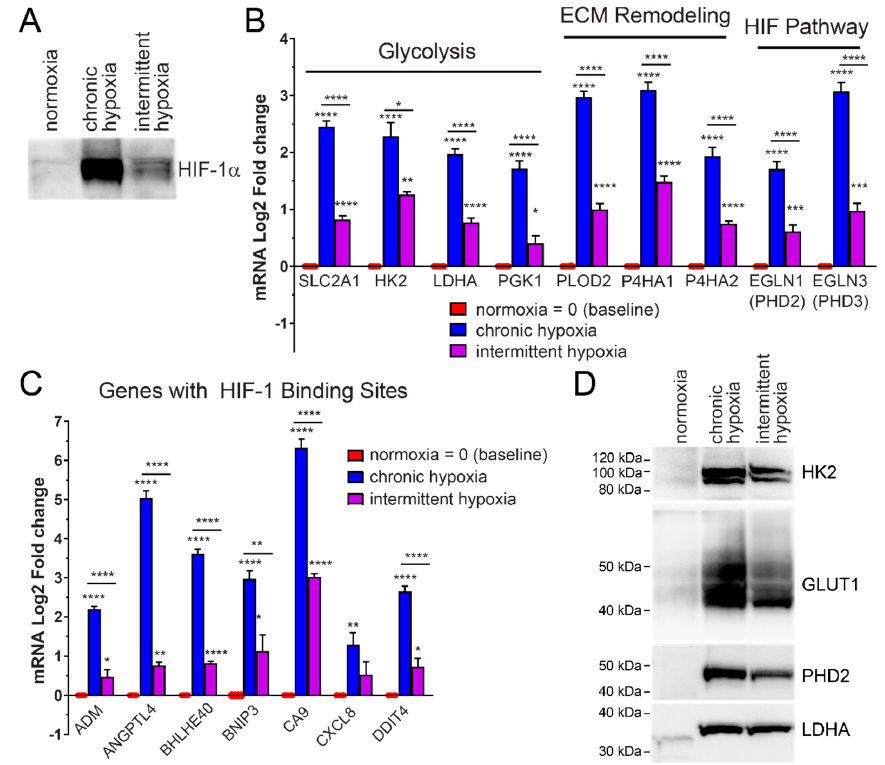
Figure 3. HIF-1 α protein increases in HCT116 cells exposed to rapid intermittent hypoxia.